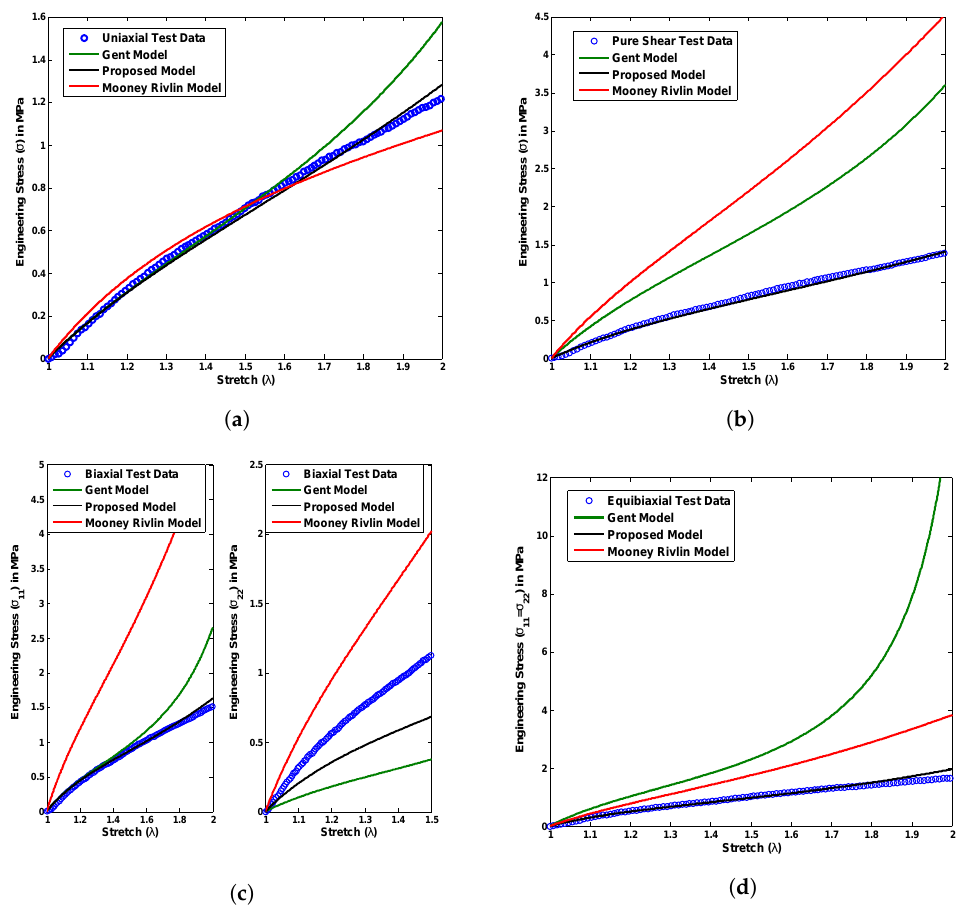
Figure 6. Experimental validation of the proposed model with Oppo test data compared to the existing material models under all possible deformation modes, ( a ) uniaxial, ( b ) pure shear, ( c ) biaxial, and ( d ) equibiaxial for a single set of material constants.